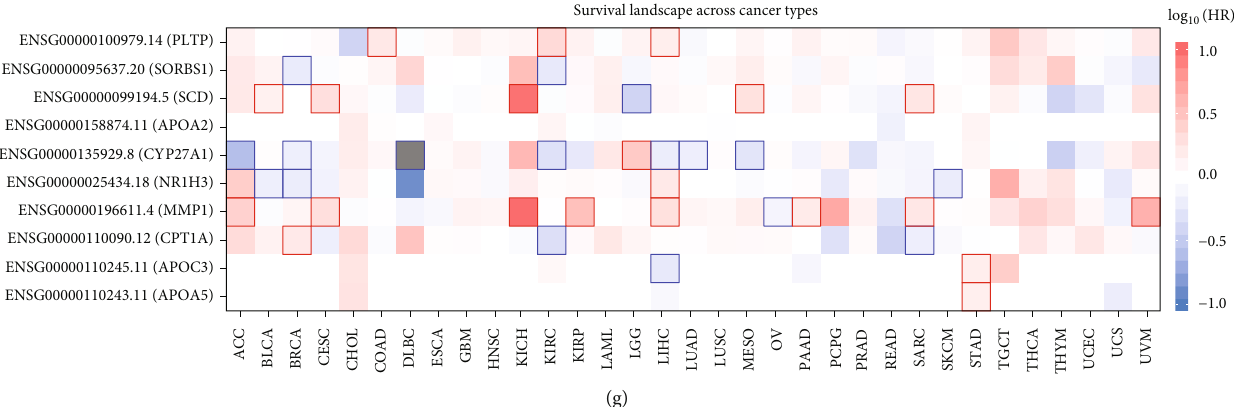
Figure 5: Variation analysis and overall survival analysis of this risk model gene in pancancer. (a – c) CNV of the risk model genes in pancancer. The light red Hete Amp represents heterozygous ampli fi cation, the light green Hete Del means heterozygous deletion, the dark red Homo Amp represents homozygous ampli fi cation, the dark green Homo Del represents homozygous deletion, and the gray represents no CNV occurrence. (d – f) SNV of the risk model genes in pancancer. The redder the color, the higher the mutation rate. (g) Survival landscape of the risk model genes in